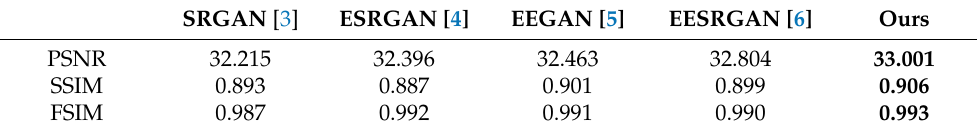
Table 5. SR result performance comparison in the Kaggle dataset, where the best results are shown in